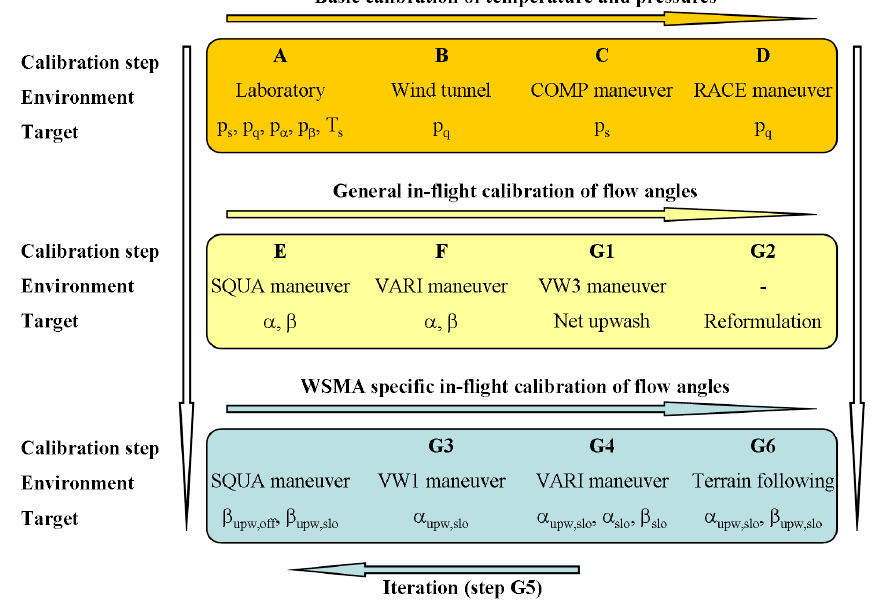
Fig. 6. Flow chart of the calibration process. The calibration Steps A–G are carried out in a sequence from left to right, top to bottom. Each step results in an incrementally refined system. The iterative Step G5 (blue background) comprises the three flight manoeuvres SQUA, VW1 and VARI. Within G5 the SQUA manoeuvre is not associated with an individual calibration step. Step C – Tower fly-bys: Adjustment of static pressure ( p s